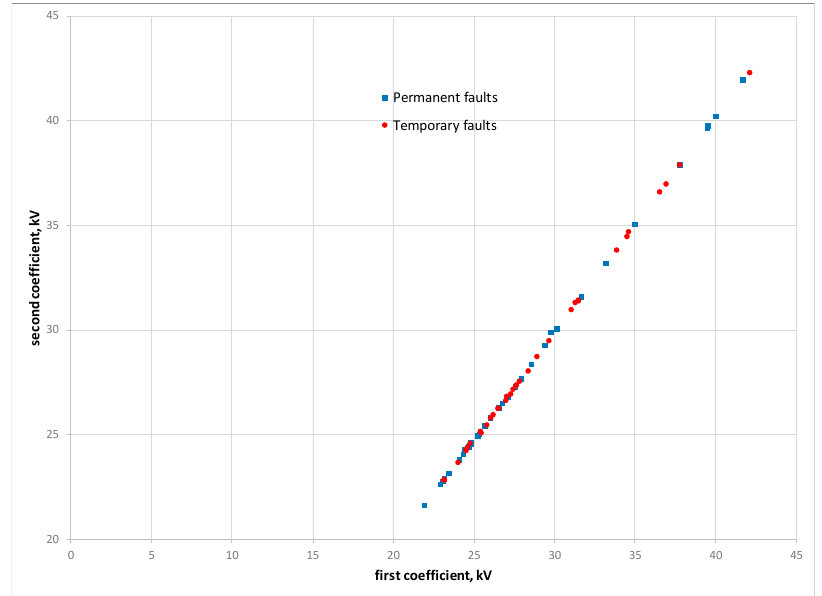
Figure 12. Permanent and temporary faults projected on the first two coefficients of the Multiresolution Analysis (MRA).